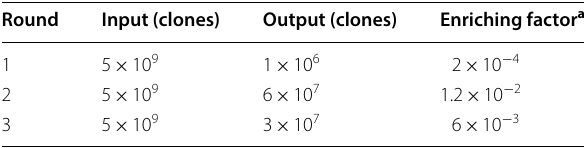
a Enriching factor